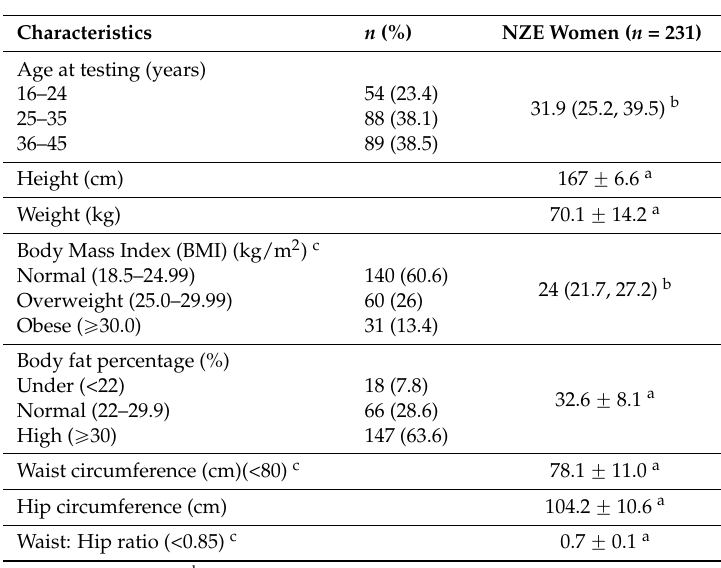
Table 1. Characteristics of all New Zealand European participants.